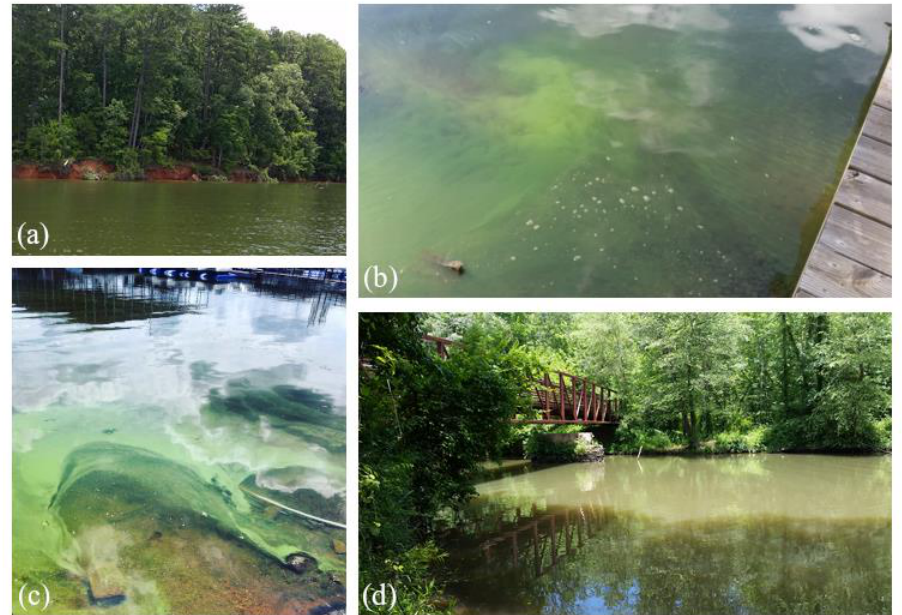
Figure 6. Lake Allatoona water quality during the 2017 warm season. ( a ) Open water near the Etowah River site; ( b ) Algal bloom with long, fibrous texture near the Little River sampling point; ( c ) Algal bloom in shallow waters in the Little River embayment; ( d ) Little River tributary upriver of Lake Allatoona. Photograph (c) by James Tullius, 2017, used with